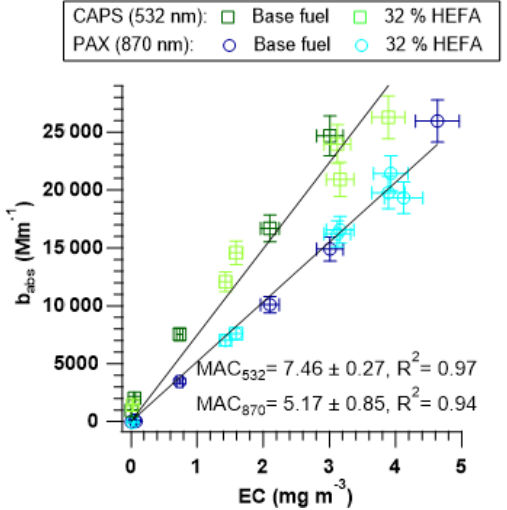
Figure 5. Scatter plot and linear regression lines between the ab- sorption coefficient ( b abs ) measured at 532nm (green squares) and 870nm (blue circles) and the elemental carbon (EC) mass concen- tration. Mass absorption cross section (MAC) values are retrieved from the slope of the linear fits. Note that dark colours represent measurements with base fuel (Jet A-1), and light colours represent measurements with the HEFA blend